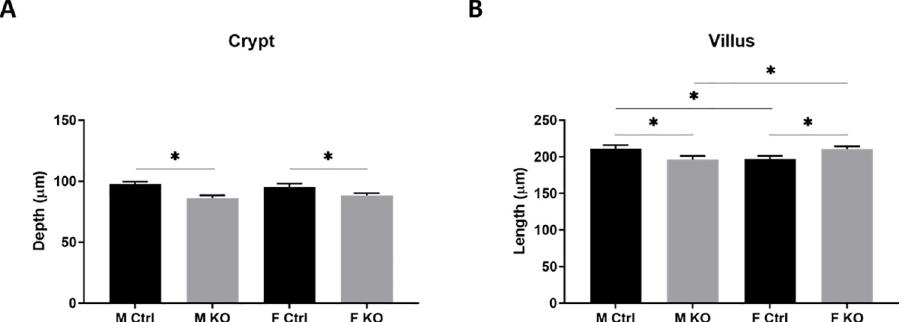
Fig 3. Villi length and crypt depth in VC-Slfn3KO mice. VC-Slfn3KO mice do exhibit (A) villus length and (B) crypt depth that is different from Ctrl mice. (n = 4 mice/group, average of 13–21 villi per sample, average of 14–24 crypts per